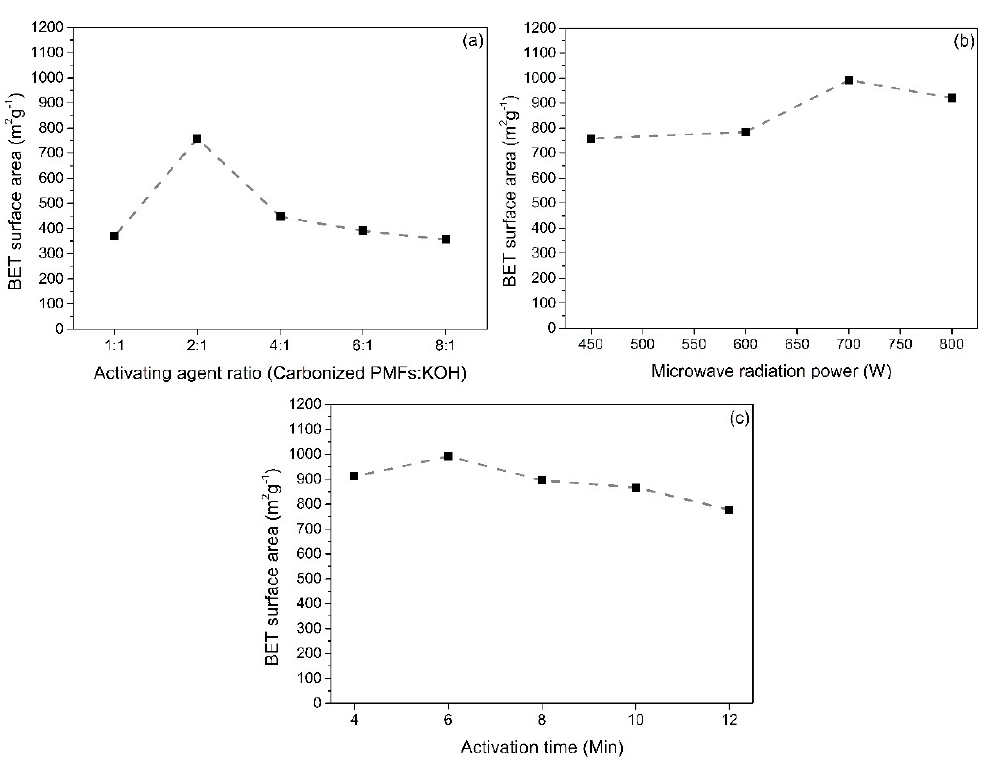
Figure 3. Effect of ( a ) activating agent ratio, ( b ) microwave radiation power, and ( c ) activation time on Brunauer–Emmett–Teller (BET) surface areas of PMFCs.